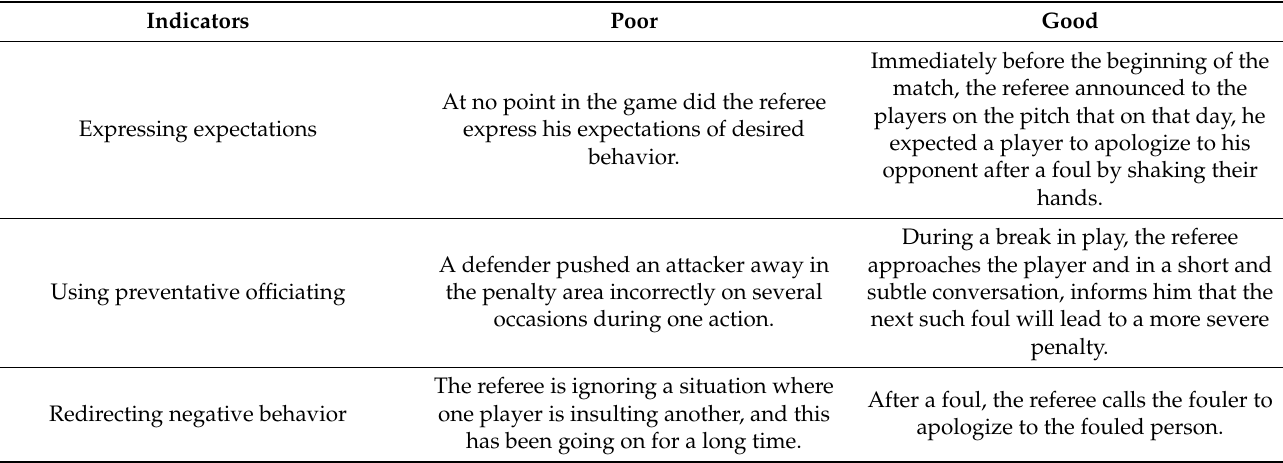
Table 2. Examples of low-quality and high-quality referee–player interactions in the dimension of positive behavior manage- ment .